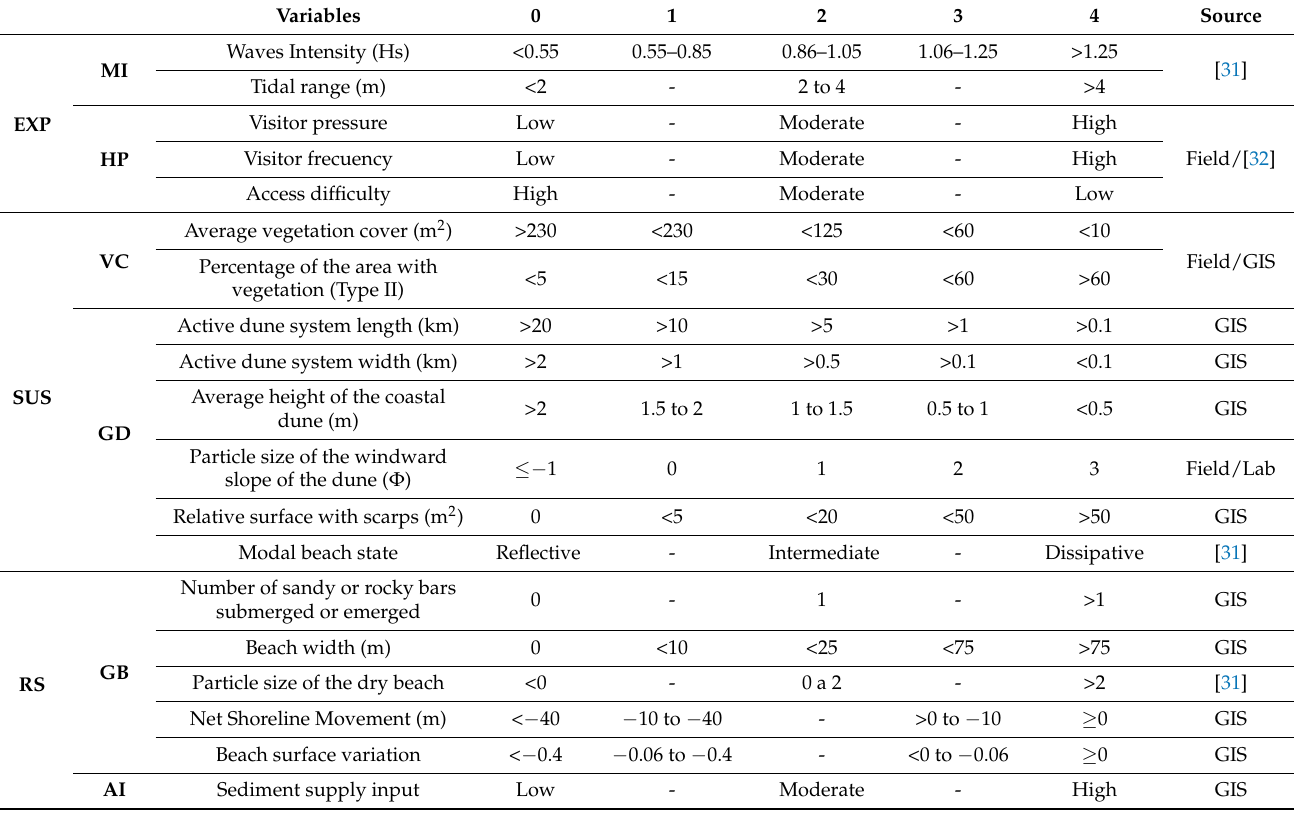
Table 1. Variables considered that were reproduced from Garc í a Mora et al. [11], Ley et al. [7], and Peña-Alonso et al. [16]. All variables were normalized between 0 to 4 values, where 0 implies the minimum and 4 the maximum value. Legend: MI: marine influence; HP: human pressure; VC: vegetation cover; GD: geomorphology of the dune system; GB: geomorphology of the beach: AI: aeolian influence; EXP: exposure; SUS: Susceptibility; RS: